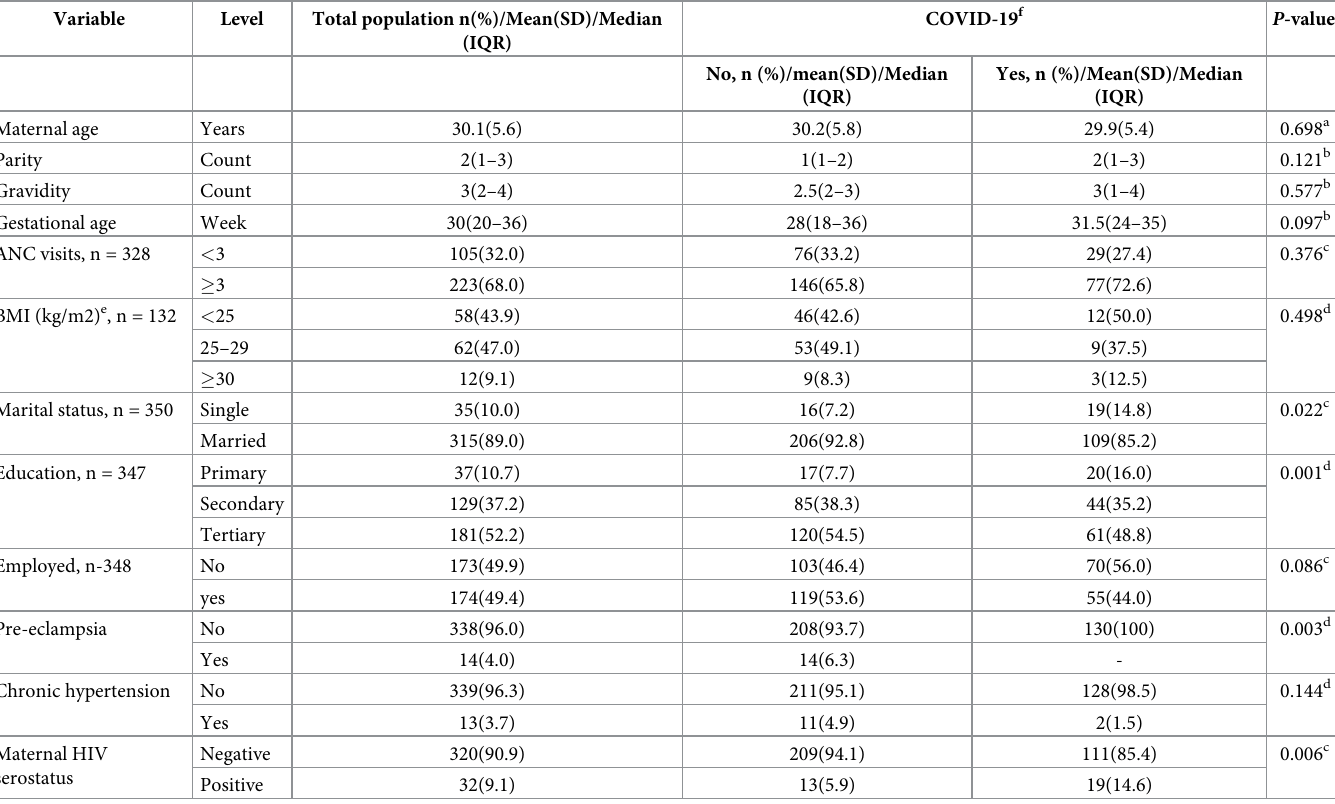
Table 1. Demographic, obstetric and clinical characteristics of study participants by COVID-19 status, N = 352.